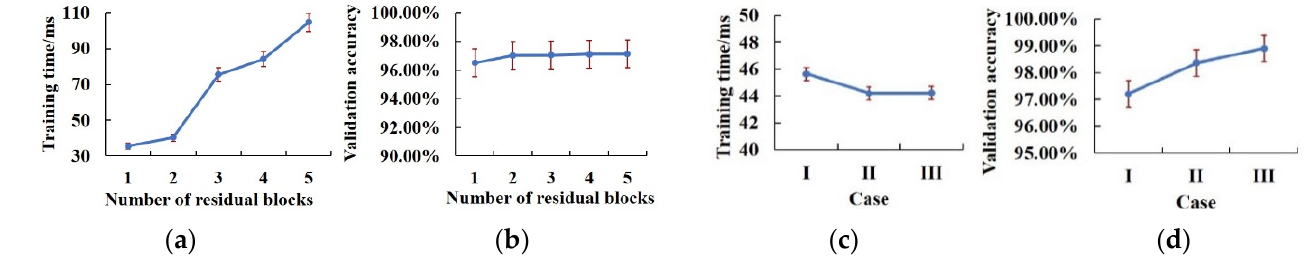
Figure 6. Validation results with different numbers of residual blocks, ( a ) training time, ( b ) accuracy; and validation results of the three cases, ( c ) training time, ( d ) accuracy.